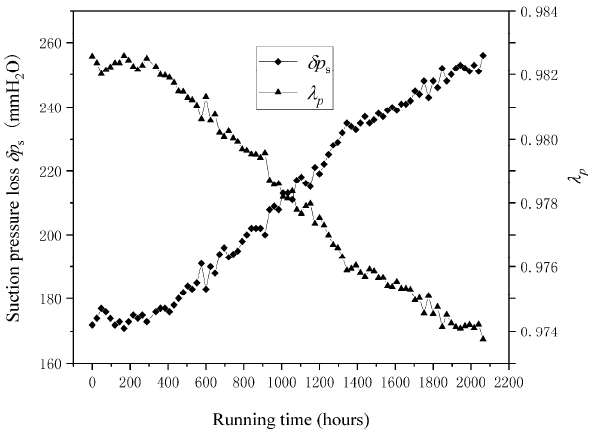
Figure 8. The pressure loss of the air filter and the pressure coefficient.